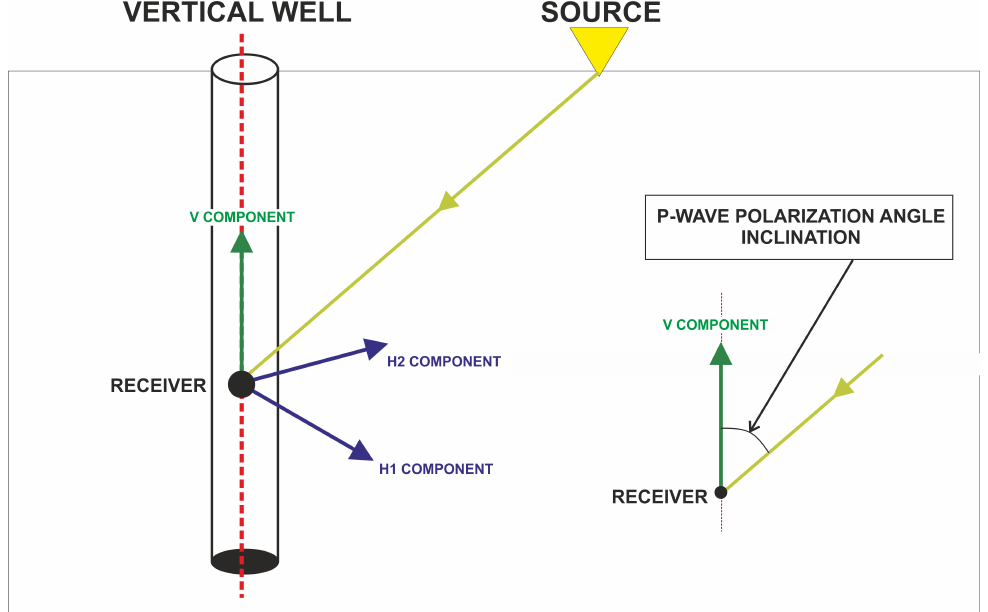
Figure 6. A measurement scheme diagram together with the explanation of the nomenclature used in this